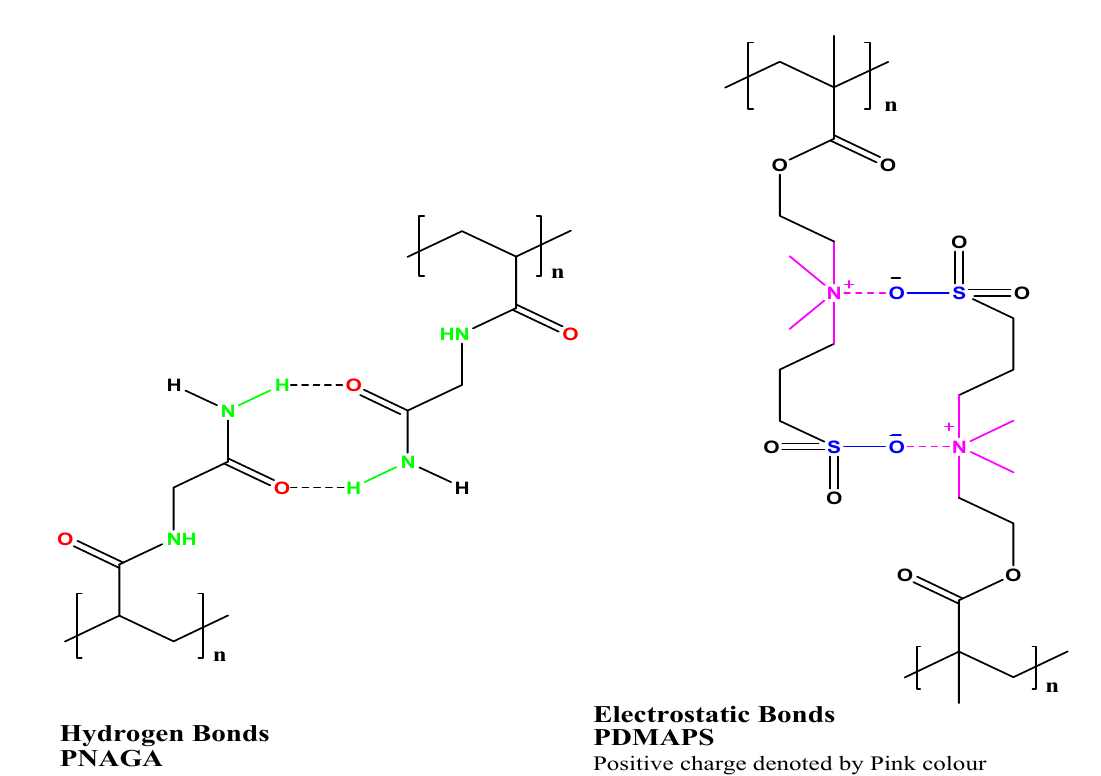
Figure 4. Thermoresponsive behaviors in the UCST copolymers are achieved by hydrogen bonds between poly( N -acryloyl glycinamide) polymer chains and electrostatic bonds between zwitterionic groups in poly( N , N (cid:48) -dimethyl(methacryloylethyl)ammonium propane-sulfonate). Reproduced from Niskanen et al. [44], with the kind permission of the copyright holder, Royal Society of Chemistry, an open access article distributed under the Creative Commons Attribution License that permits unrestricted use, distribution, and reproduction in any medium.